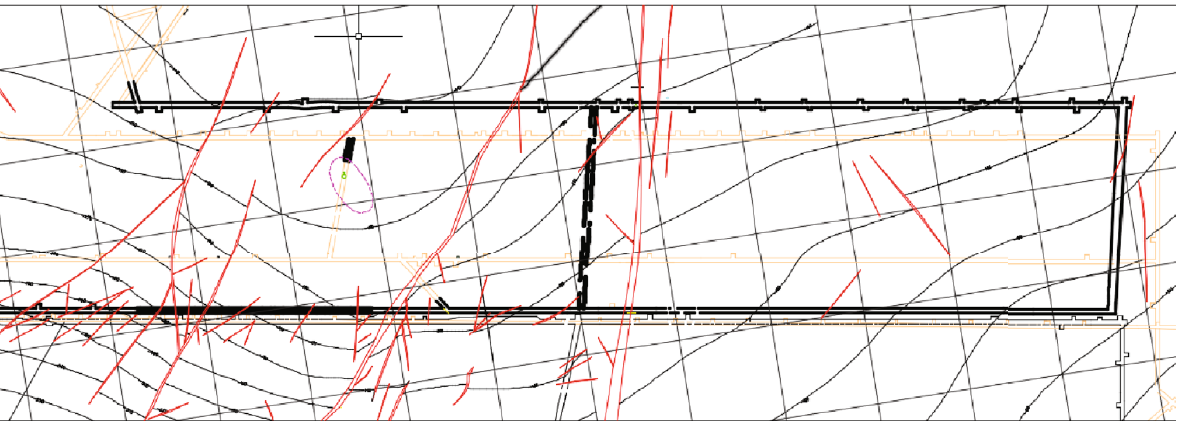
Figure 3: 12123 working face diagram.